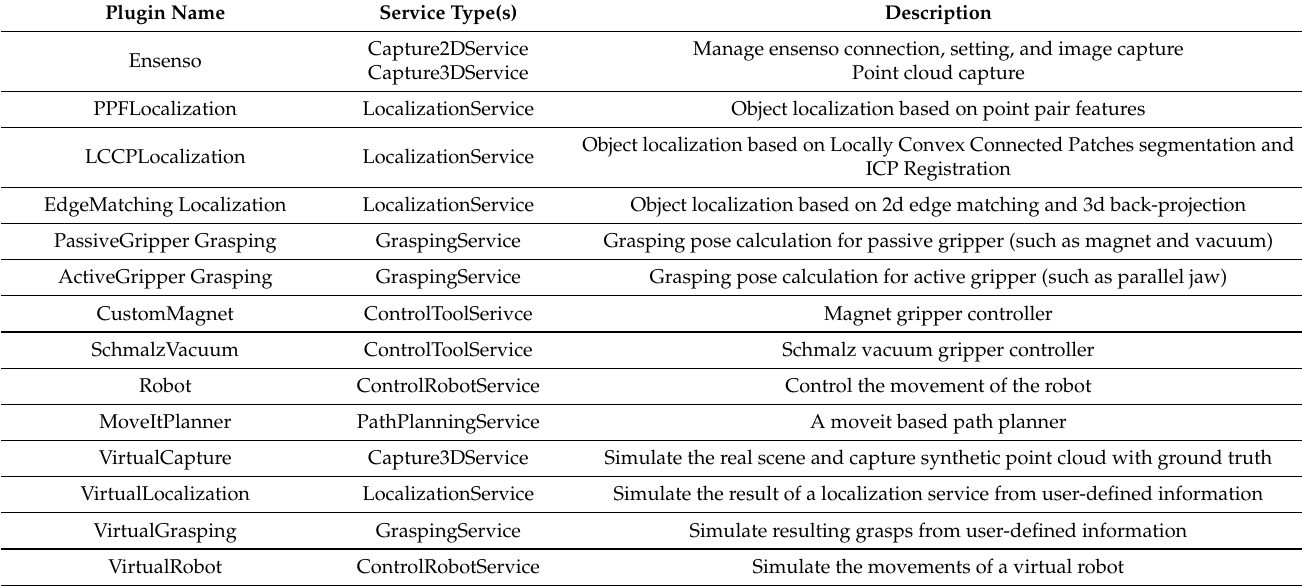
Table 1. List of available services in